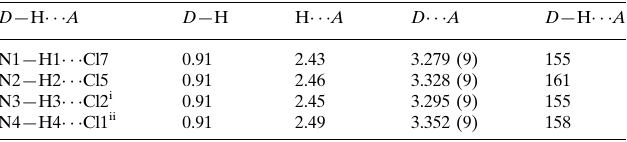
Hydrogen-bond geometry (A˚ , (cid:2)